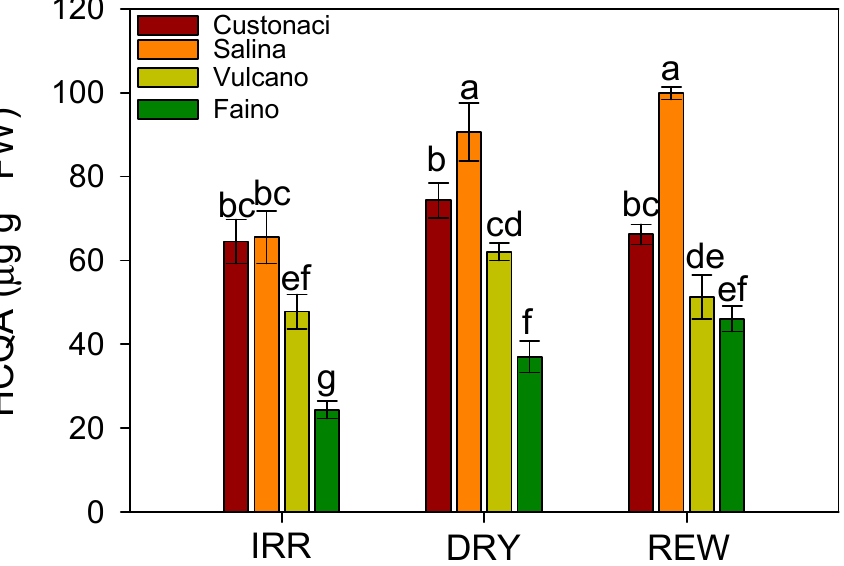
Figure 5. HCQA content in fruits of four cultivars of tomato in response to irrigation (IRR: full irrigation; DRY: no irrigation; REW: rewatering). Bars are mean value ± standard error ( n = 3). Different letters among cultivars across irrigation treatments indicate significance at p ≤ 0.05 by Tukey’s test.